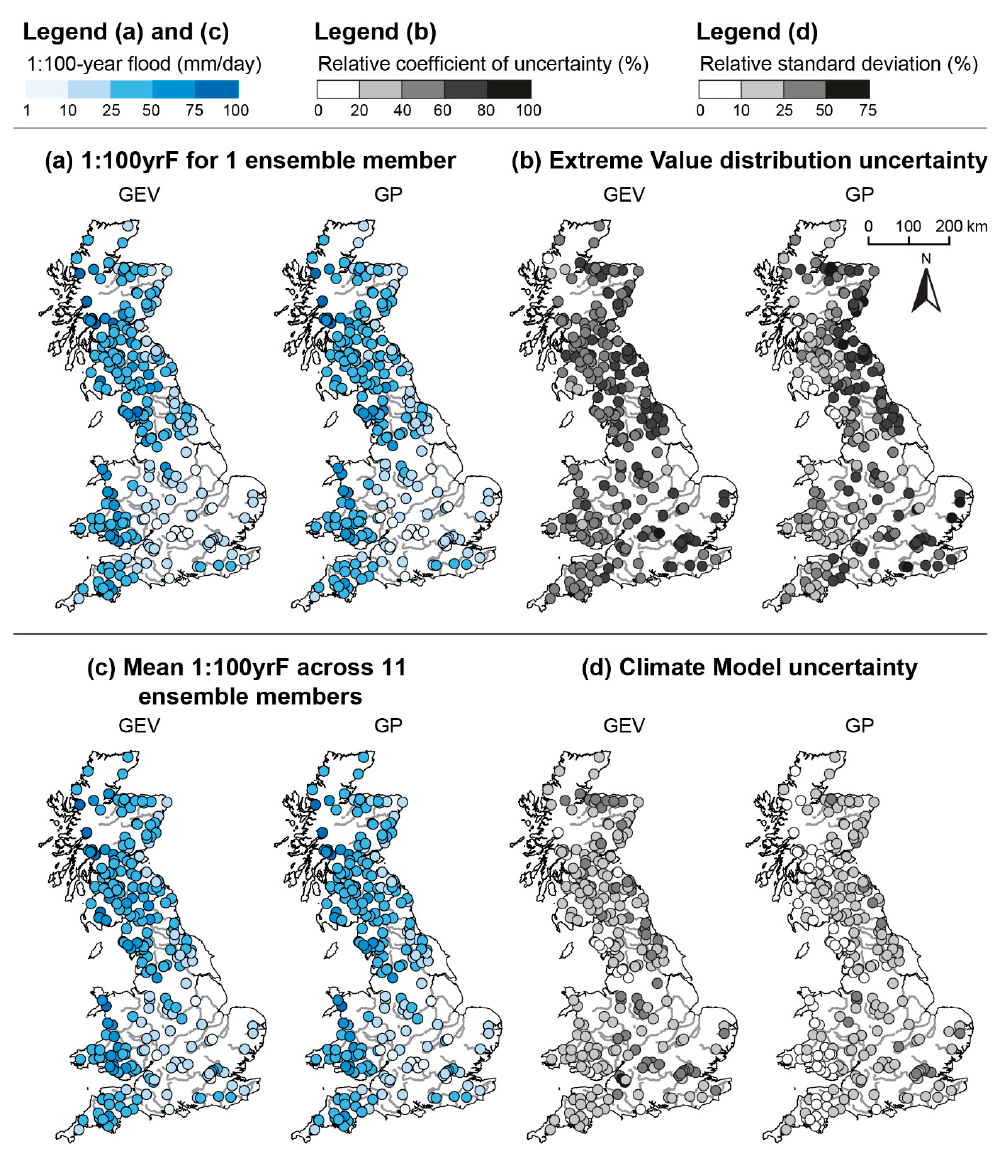
Figure 3. Results across Great Britain over the baseline for the GEV (on the left) and the GP (on the right) models. Step 1: ( a ) 1:100 yrF (for ensemble member afgcx); and ( b ) Extreme Value Distribution parameter uncertainty (relative coefficient of uncertainty). Step 2: ( c ) Mean 1:100 yrF across the 11 ensemble membersl and ( d ) Climate Model uncertainty (relative standard deviation).